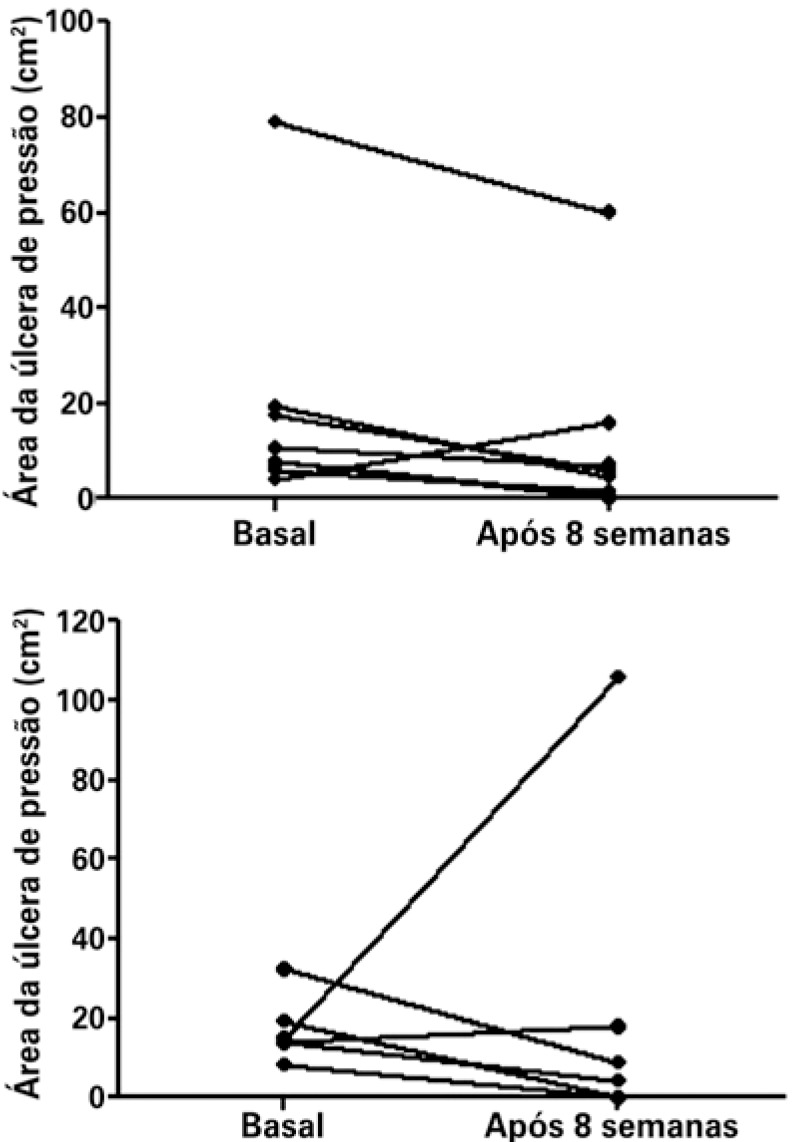
Dimensões das úlceras por pressão (cm2) em 11 pacientes internados em hospital de longa permanência antes a após o tratamento com (A) colagenase (n=8) e com (B) sulfadiazina (n=6) por 8 semanas. Não foram observadas diferenças significativas entre os valores basais e após tratamento no tempo acompanhado (p>0,05)